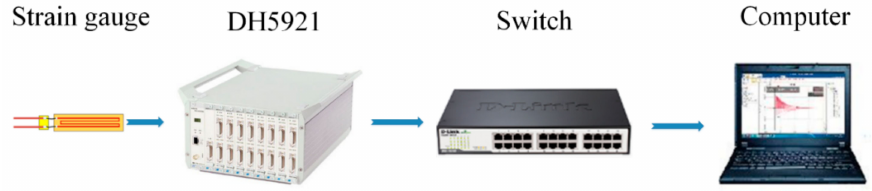
Figure 8. Data acquisition